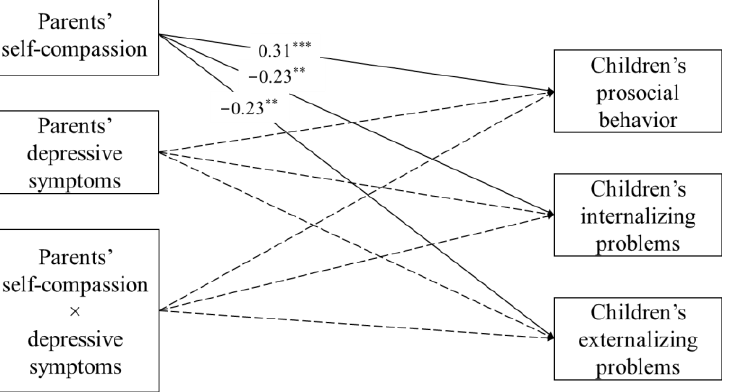
Figure 2. Final moderation model of parents’ self-compassion and depressive symptoms on child adjustment. χ 2 (2) = 1.35, p > 0.05, CFI = 1.00, TLI = 1.06, RMSEA = 0.00, SRMR = 0.01. Covariates including monthly family income and child and parent gender were included as control variables but are not depicted in the figure for clarity. Non-significant paths are shown in dashed arrows. ** p < 0.01, *** p < 0.001.